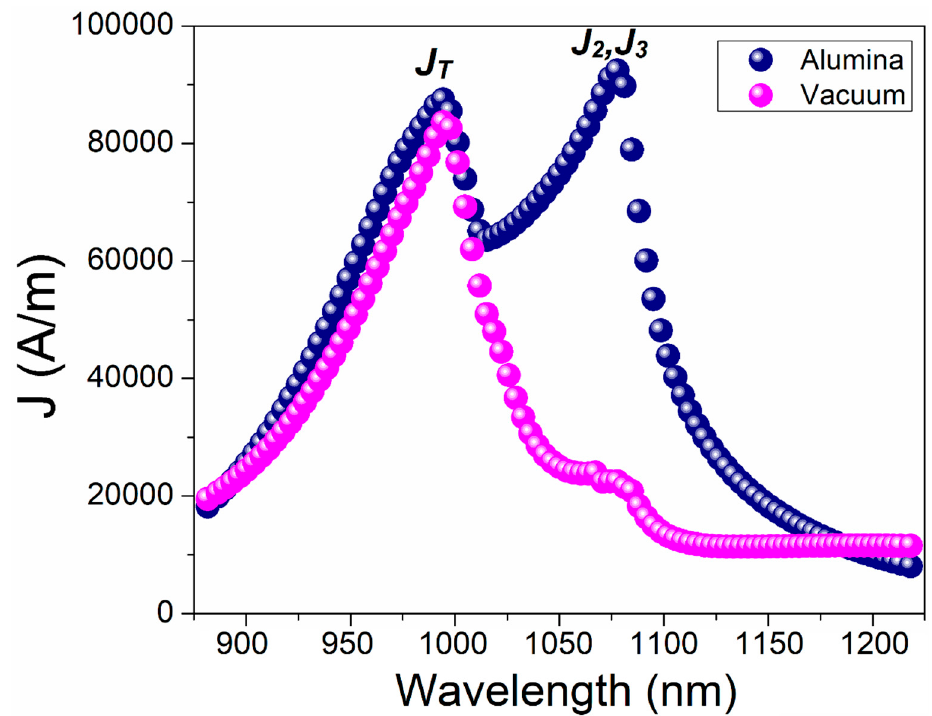
Figure 5. The characteristic surface current density map as a function of incidence, calculated for vacuum and alumina-filled gap regimes, showing the contribution of the super-toroidal mode in the formation of a second current density extreme.